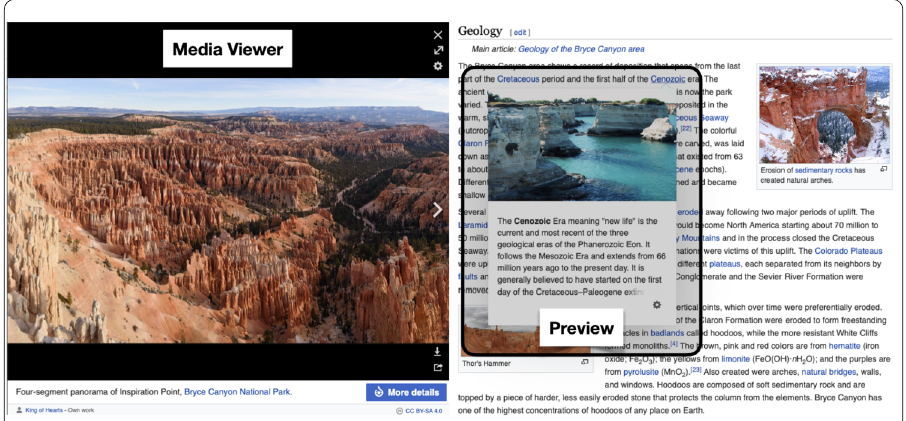
Figure 1 Examples of the two types of images visualization that we investigate in this study. The Media Viewer is opened when images are clicked, while Page Previews are shown when the reader hovers over a link to another